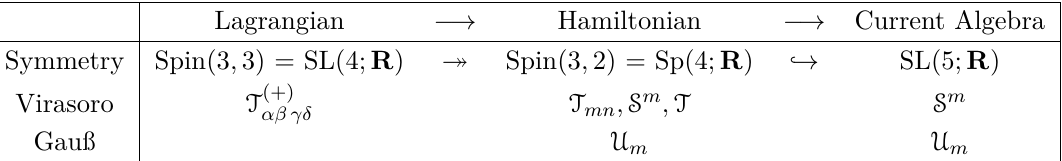
Table 1 . Symmetry breaking and enhancement in the 5-brane system (rank 4). The Lagrangian description of the dynamics preserves a larger symmetry than the Hamiltonian description. On the other hand, the Virasoro+Gauß algebra contains a kinematic subalgebra generated by S and U preserving a higher-rank exceptional